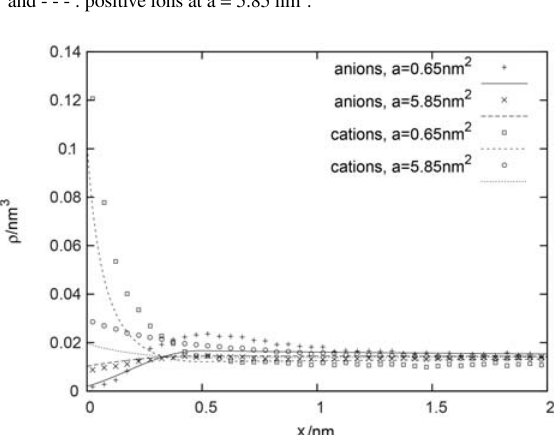
Figure 3. Density profiles of small mobile ions next to the zwitte- rionic layer at Debye length equal to 2 nm. Notation is the same as for Figure 2, except for the corresponding monovalent salt concen- tration, which is 0.023